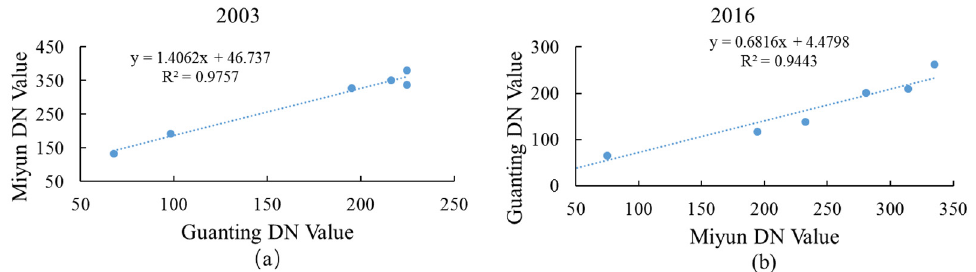
Figure 9. Estimates of regression curves of standard deviation of Landsat image bands’ DN values in Guanting Reservoir and Miyun Reservoir. The value of Guanting reservoir was used as a dependent variable to match the value of Miyun reservoir in 2003 ( a ). The value of Miyun reservoir was used as the dependent variable to match the value of Guanting reservoir in 2016 ( b